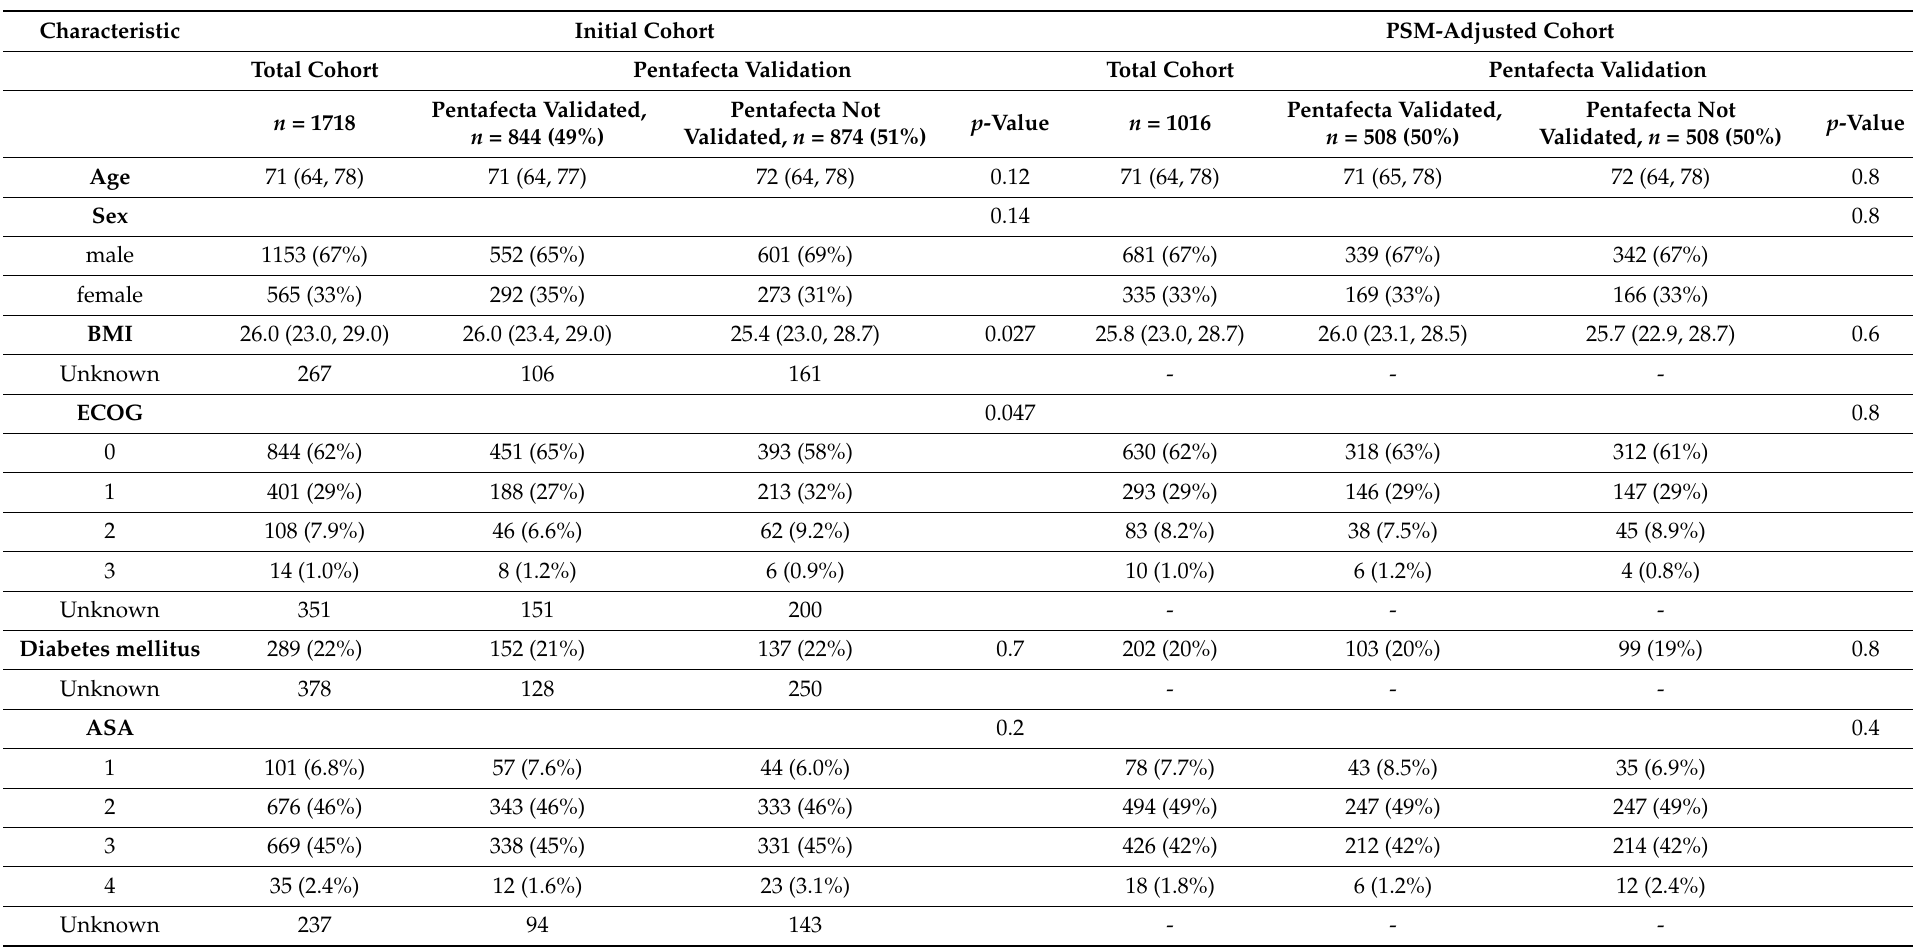
Table 1. Clinicopathological characteristics of 1718 patients treated with RNU for high-risk UTUC, initial cohort ( left ) and after propensity-score-matching adjustment ( right ), both stratified by pentafecta validation. PSM = propensity-score matching; BMI = Body mass index; ECOG = Eastern Cooperative Oncology Group Status; ASA = American Society of Anesthesiologists Score; NAC = Neoadjuvant chemotherapy; IQR = interquartile